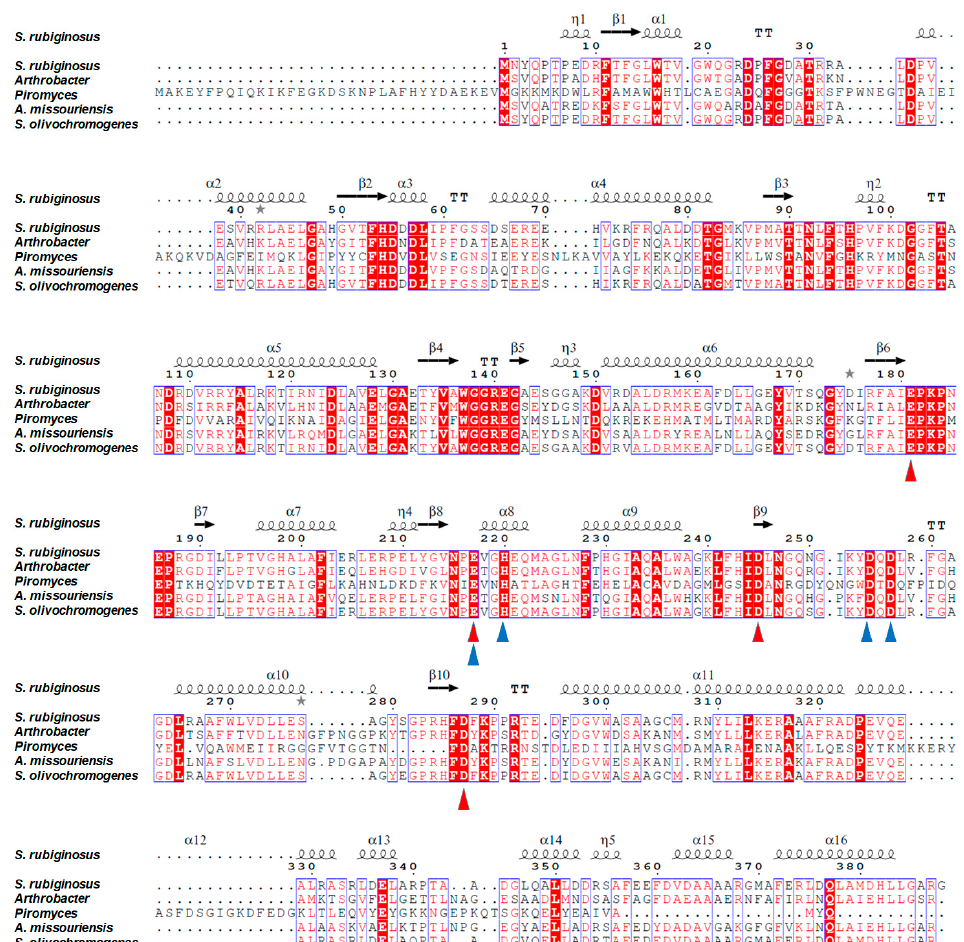
Figure 4. Amino acid sequence alignment of GIs from Streptomyces rubiginosus (UniProt Accession: P24300), Arthrobacter sp. NRRL B3728 (P12070), Piromyces sp. E2 (Q9P8C9), Actinoplanes missouriensis (P12851), and Streptomyces olivochromogenes (P15587). Residues involved in metal binding at the M1 and M2 sites are indicated by red and blue triangles, respectively. Alignment was performed using Clustal Omega [38] and displayed using Espript [39].